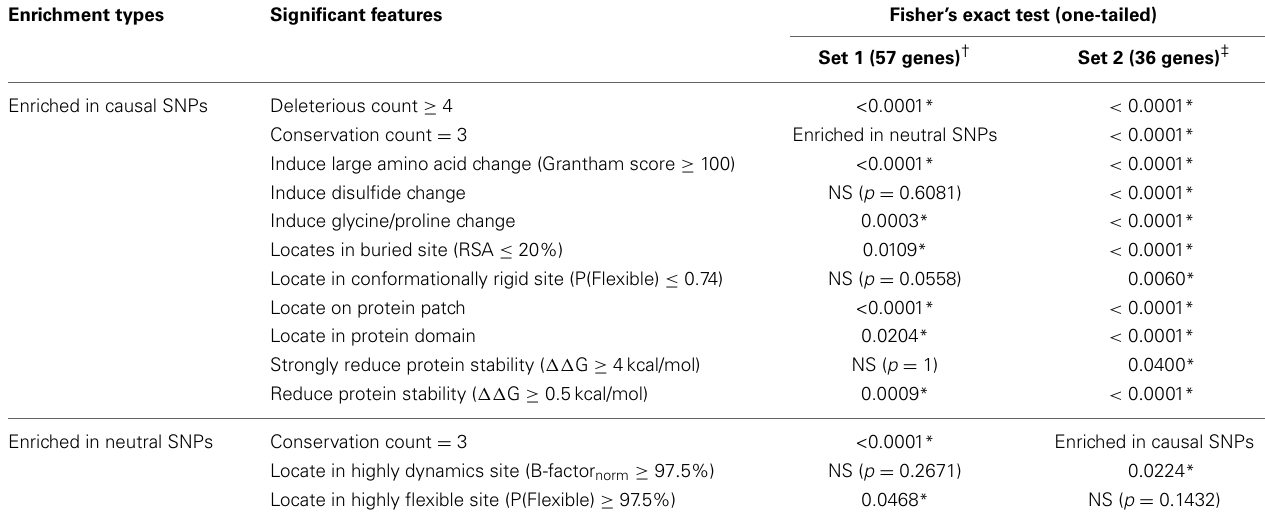
Table 4 | Fisher’s exact test statistics for gene sets 1 and